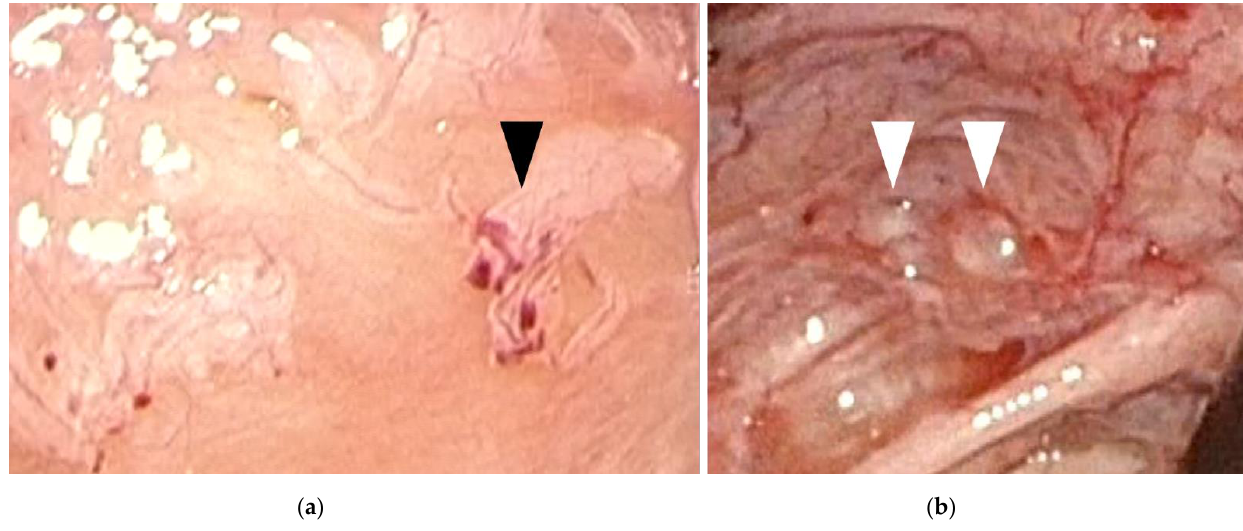
Figure 1. Early-stage endometriosis lesions found in adolescents. ( a ) Red and clear peritoneal lesions on the peritoneum (black arrowhead); ( b ) Vesicular lesions (white arrowhead) found on the peritoneum near the left uterosacral ligament.